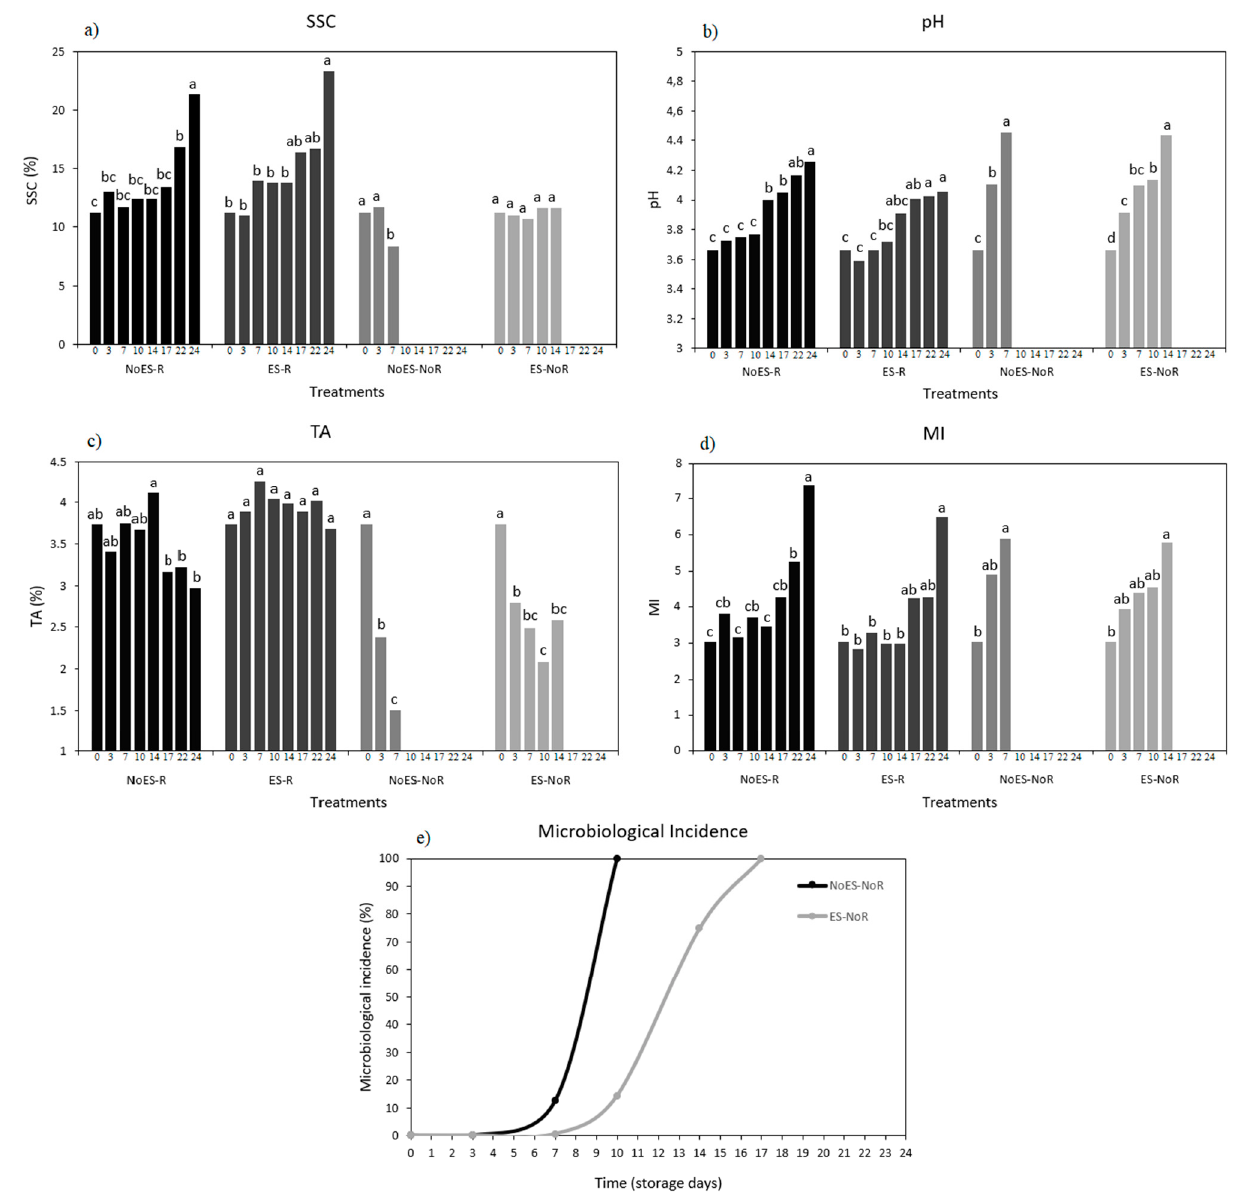
Figure 3. Soluble solid content (SSC) expressed in percentage ( a ), hydrogen potential expressed in pH units ( b ), titratable acidity (TA) calculated as malic acid equivalents and expressed as percentage ( c ), maturity index (MI) calculated as SSC/TA ratio ( d ), and microbiological incidence expressed as percentage ( e ) over the storage time (24 days) in peaches subjected to the different treatments (NoES-R, ES-R, NoES-NoR and ES-NoR). Different letters for each day in one treatment represent statistically significant differences according to Tukey’s test with the aim of assessing the evolution of each parameter for every